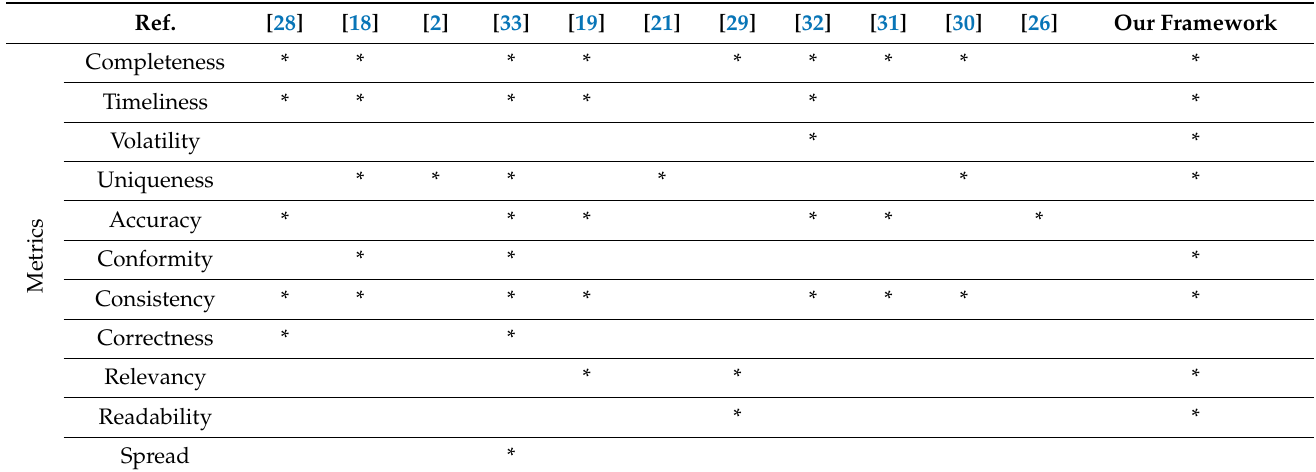
Table 13. Comparative table of used existing metrics.